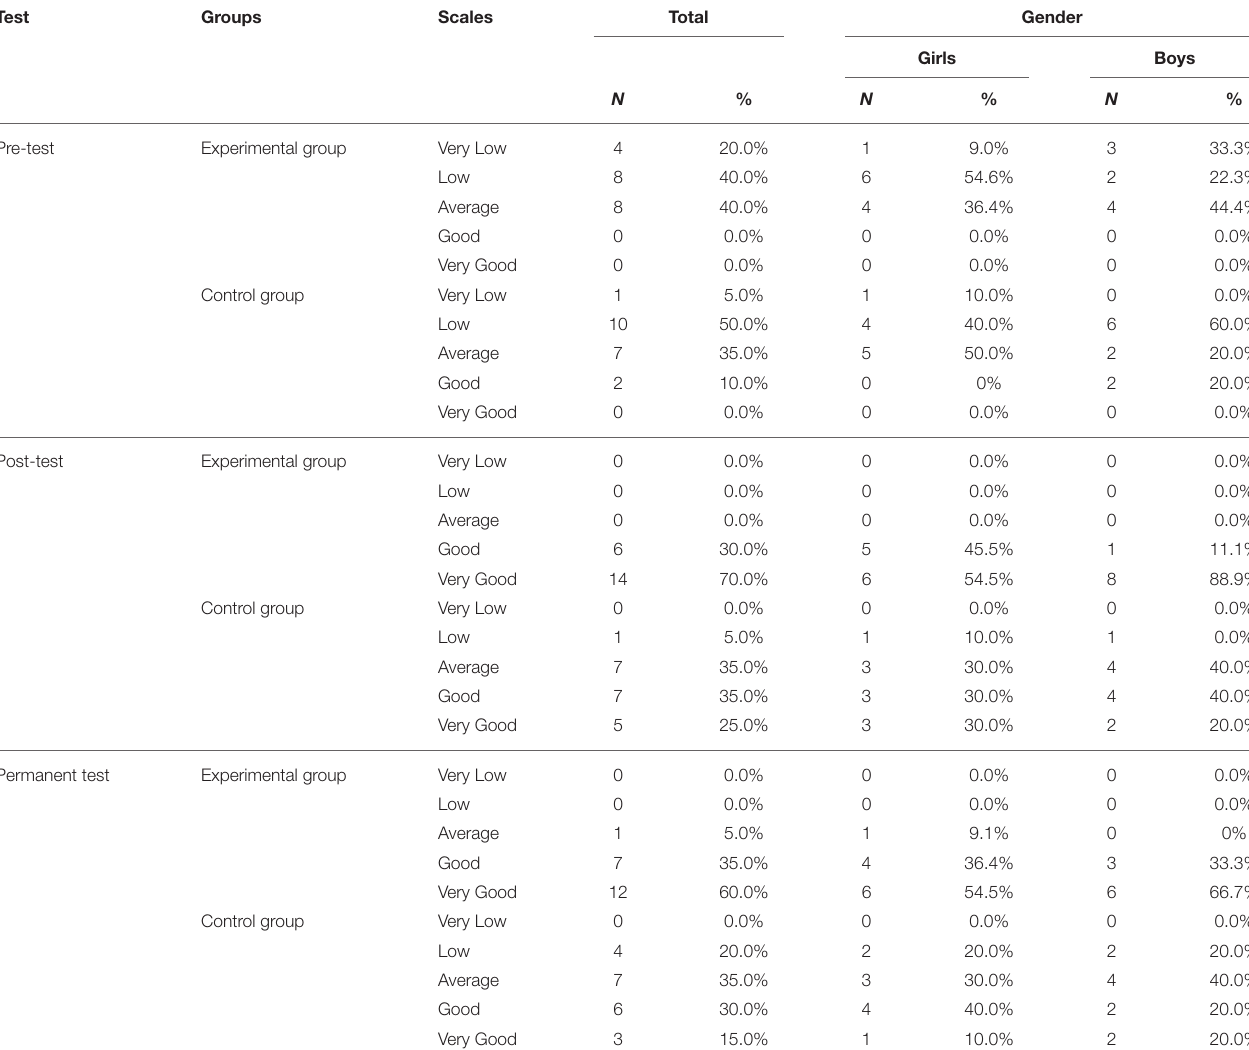
TABLE 1 | The pre-test success scales, the post- test success scales and permanent test success scales of primary school 1st grade experimental and control group students. Test